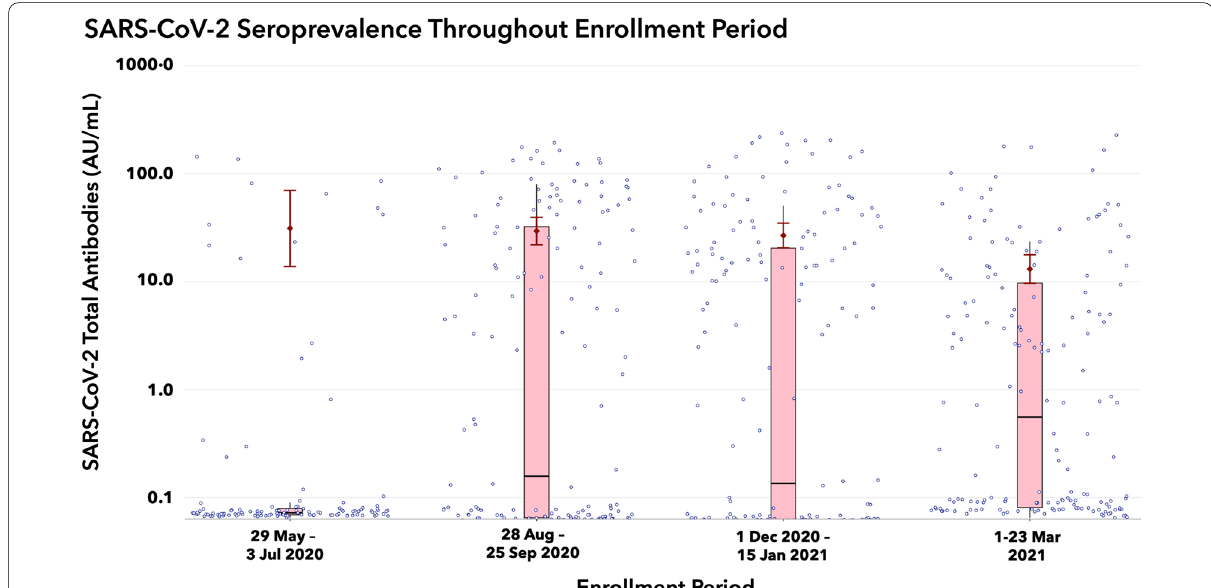
Fig. 2 Distribution of SARS-CoV-2 total antibodies across four enrollment periods ( y -axis at log base 10 scale). Blue circles indicate individual data points from all participants. Pink boxplots show the median [IQR] values of total antibodies per data collection period for all participants. Dark red error bars indicate the geometric mean concentrations and 95% confidence intervals of total antibody among seropositive individuals